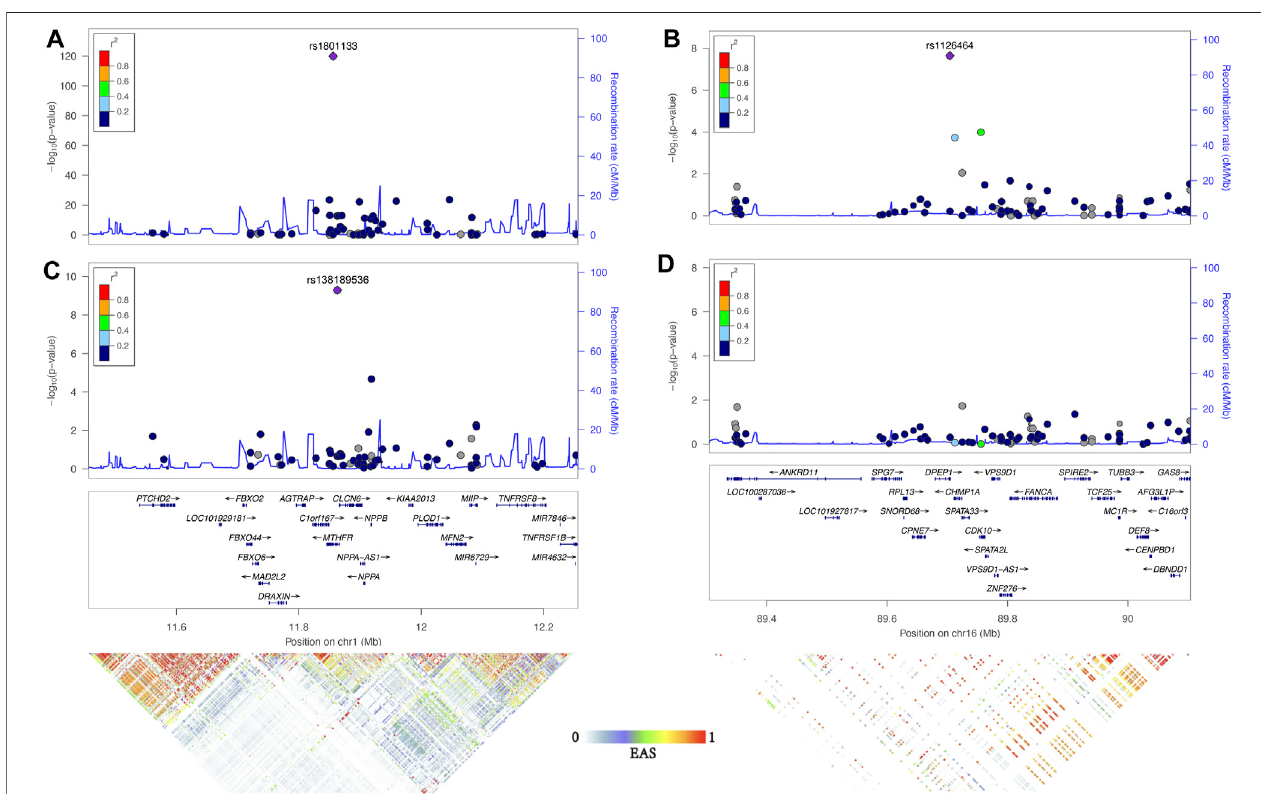
FIGURE 2 | Association of two loci signi fi cantly associate with tHCY. Regional association plots were generated by Locuszoom of 1p36.22 and 16q24.3 of the results of ExWAS ( A and B ) and conditional analysis ( C and D ) using linkage disequilibrium information from the November 2014 release of the 1000 Genomes Project ASN samples. The index SNP in each region is shown as a purple diamond. Genes in the region and LD heatmap ( r 2) patterns according to the 1000 Genomes Project EAS dataset are aligned on the bottom. tHCY, total homocysteine; ExWAS, exome-wide association study; SNP, single-nucleotide polymorphism; LD, linkage disequilibrium.